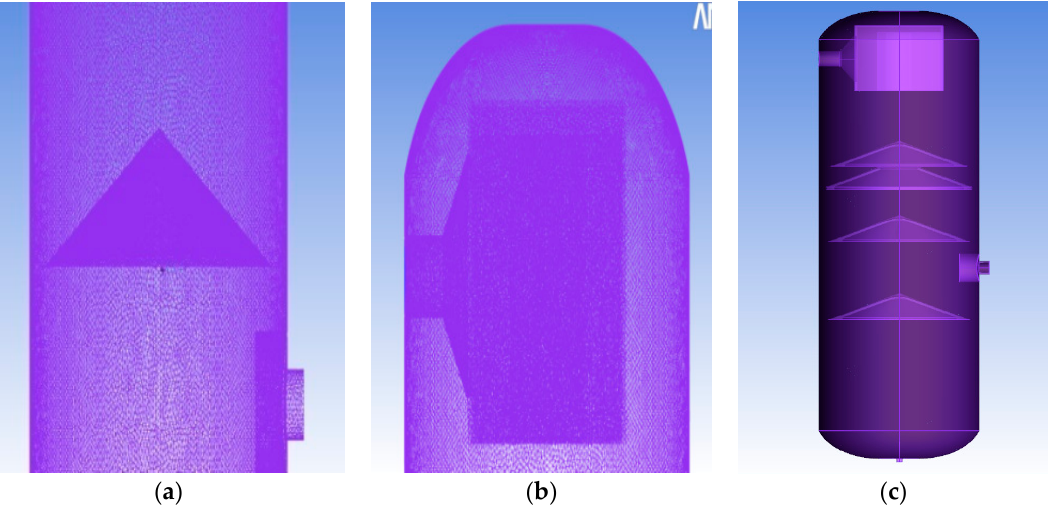
Figure 2. Showing ( a ) separation umbrella grid; ( b ) separator area of separation fine grid; ( c ) separator grid.